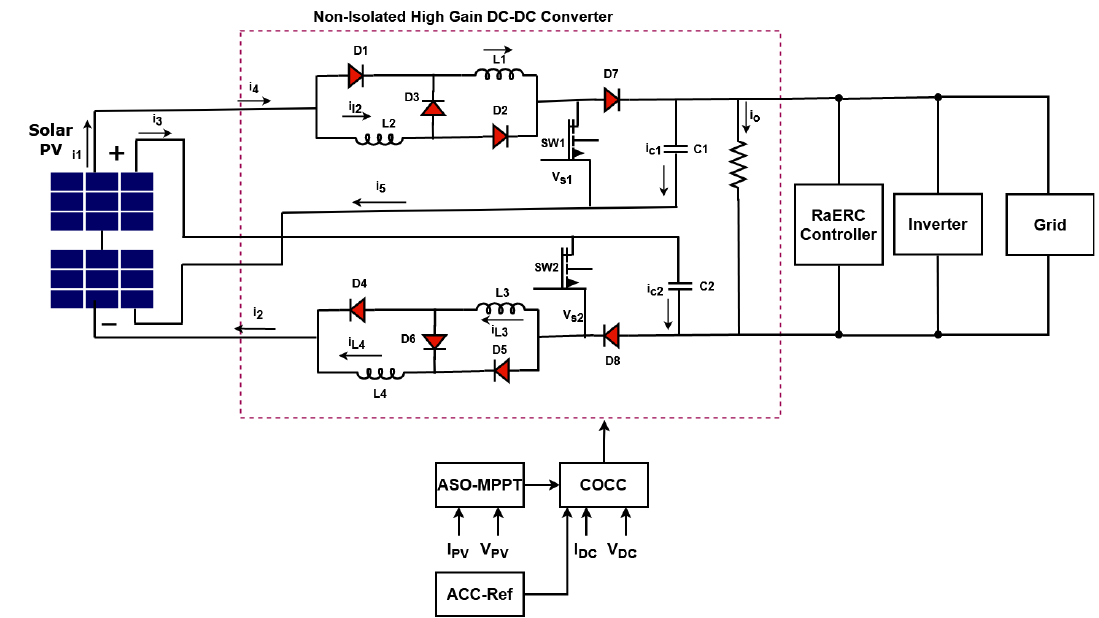
Figure 2. Schematic representation.